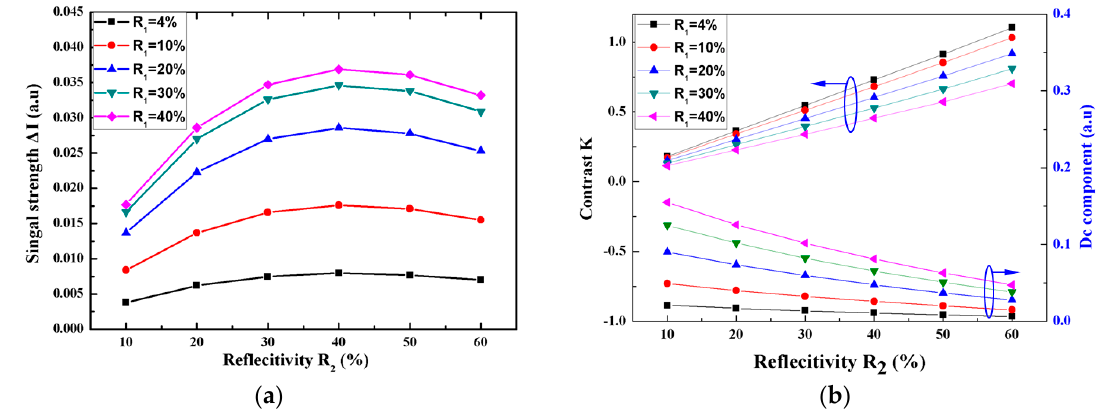
Figure 7. The key evaluation parameters simulated in different reflectivity R 1 and R 2 : ( a ) Δ I , ( b ) dc component and contrast K.